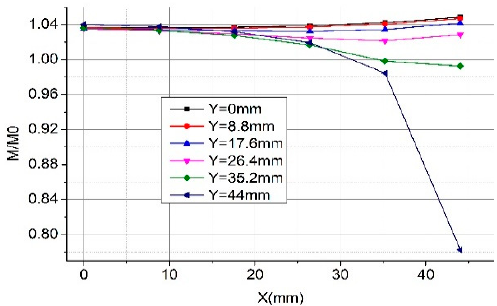
going through the outer holes.